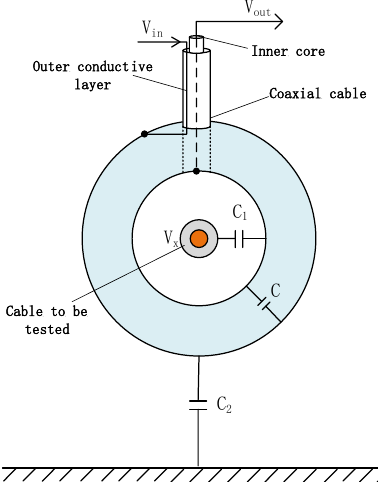
Figure 4. Cross-section of probe interface.